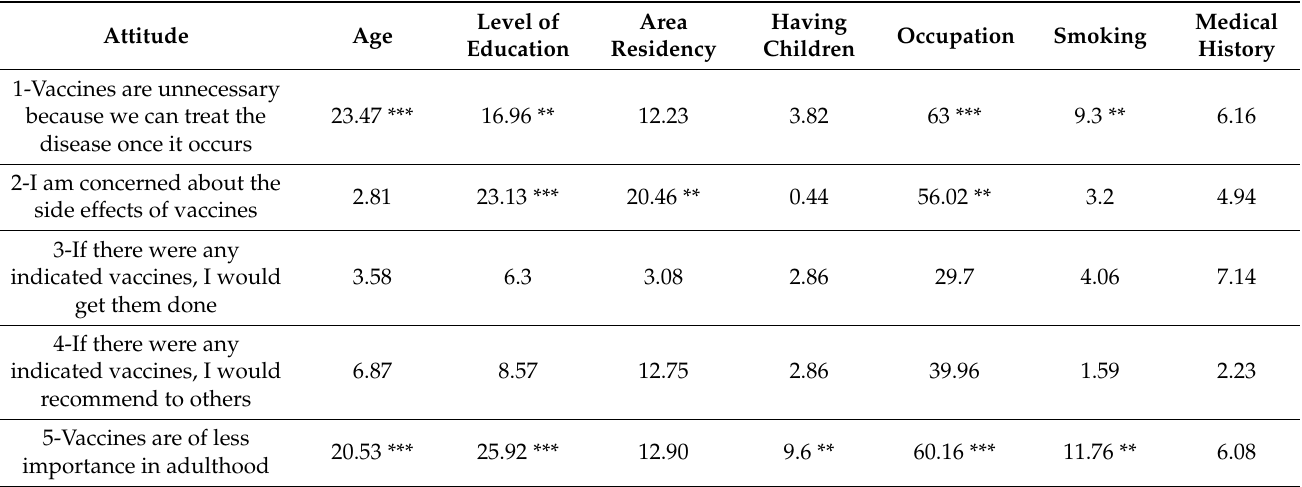
Table 5. The attitude of subjects based on Chi 2 p -value. LAUMCRH. January 2020–January